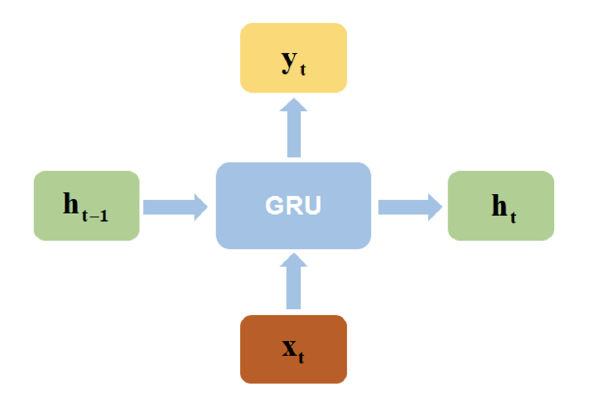
Figure 4. The external input and output structure of the GRU model.